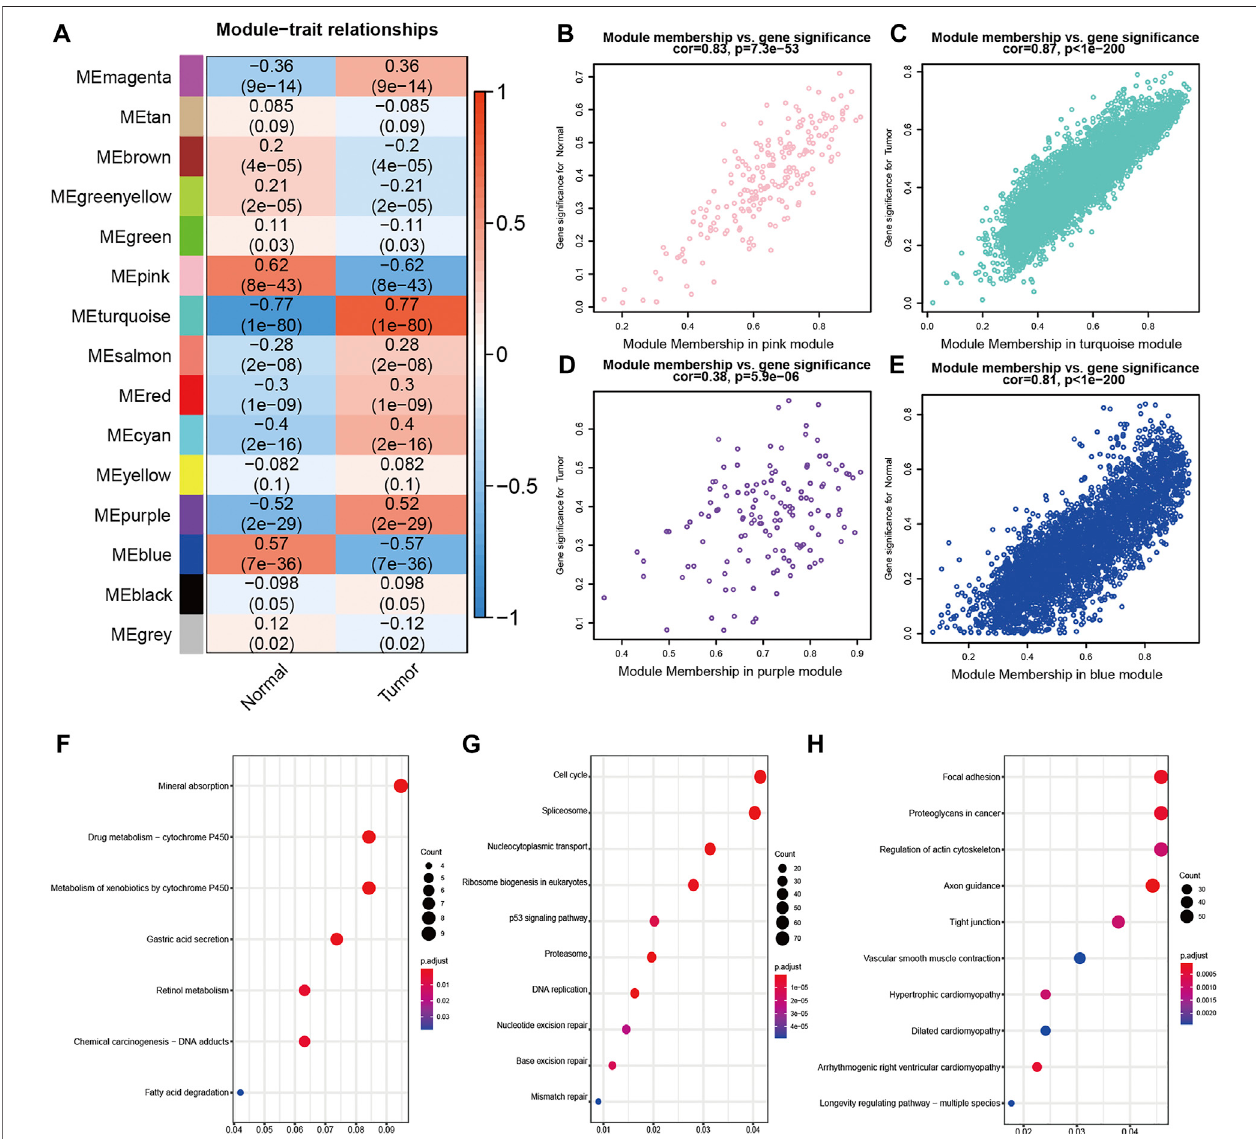
FIGURE3| Identi fi cationofsigni fi cantmodulesinWGCNA (A) Heatmapofthecorrelationbetweenmoduleeigengenesanddiseasestatus.Eachcellcontainedthe correlationcoef fi cientsand p value.Redindicatespositivecorrelationswhileblueindicatesnegative (B) – (E) ScatterplotsofGeneSigni fi cance(GS)fordiseasevsModule Membership (MM) inthepink (B) , turquoise (C) , purple (D) and blue (E) modules.There wasahighly signi fi cantcorrelation betweenGSand MM inpink, purple andblue module (F) – (H) KEGG pathway analysis in pink (F) , turquoise (G) and blue (H) modules.